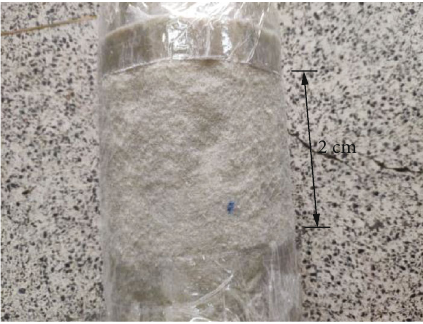
Figure 5: Schematic diagram of the slotted tube overlay geotextile.